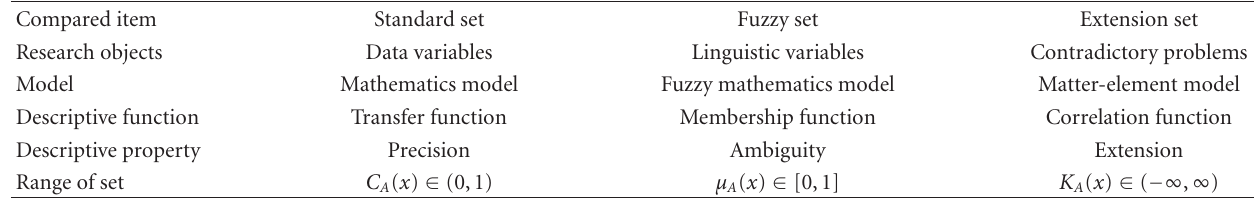
Table 1: Three di ff erent sorts of mathematical sets.